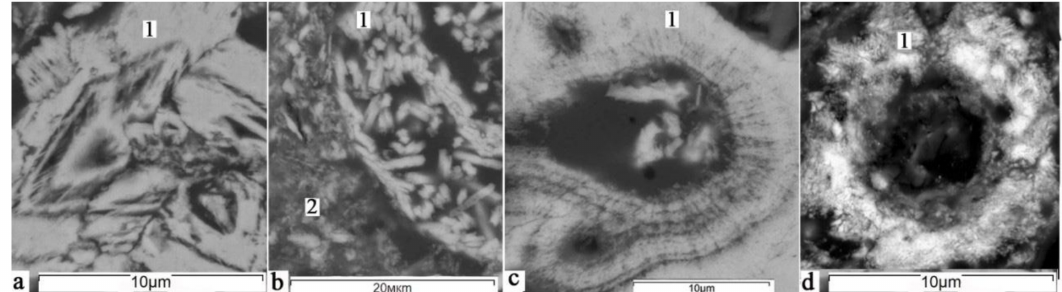
Figure 8. Microphotographs of authigenic carbonates at the water–bottom boundary. Calcite (a,b) and low-magnesium calcite (c,d): ( a ) Rhombohedral crystals of di ff erent sizes (Lake Danilovo), 1—CaCO 3 ; ( b ) 1—dendrite aggregates (presumably the fusion of thin scalenohedral crystals) and